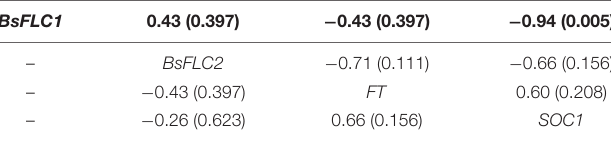
TABLE 2 | Pairwise correlation (Spearman’s ρ , with P -values in parentheses) between the expression patterns of four genes from six time points in two accessions (upper triangle, MAH; lower triangle, MR24, the accession without BsFLC1